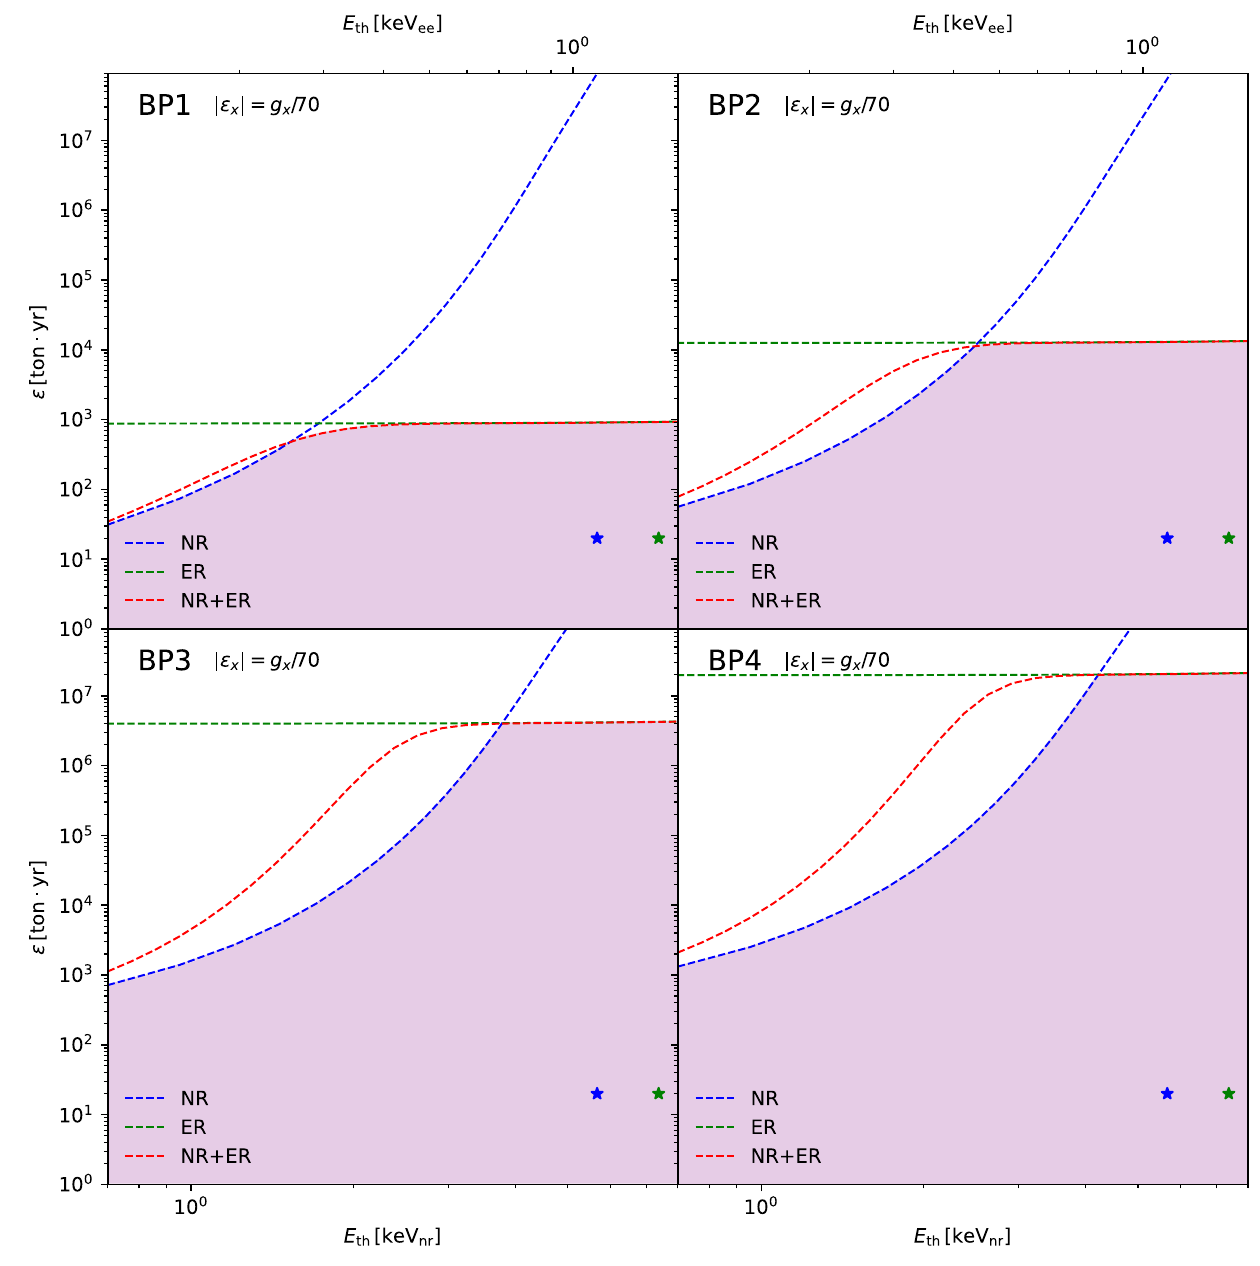
Fig. 14 The same as in Fig. 11 but for